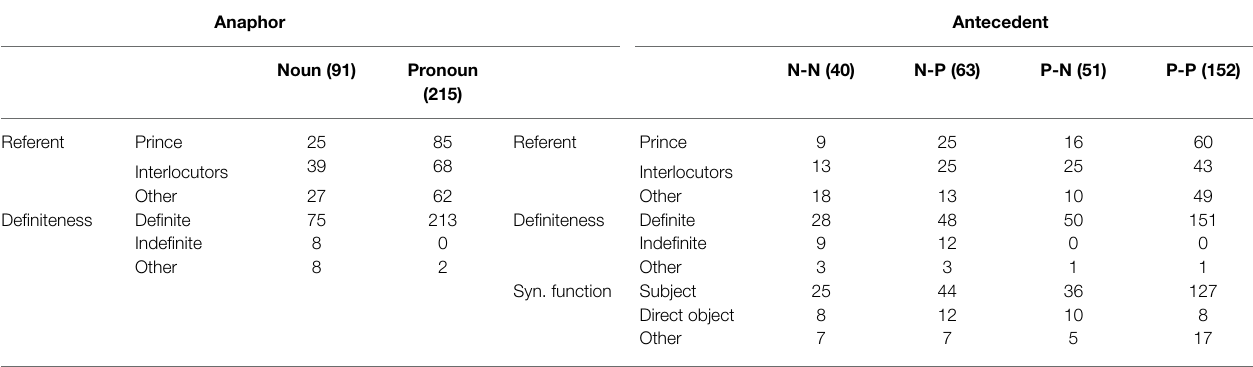
TABLE 2 | Distribution of several prominence features of anaphors and antecedents in the analyzed sample (referent identity, definiteness, and syntactic).